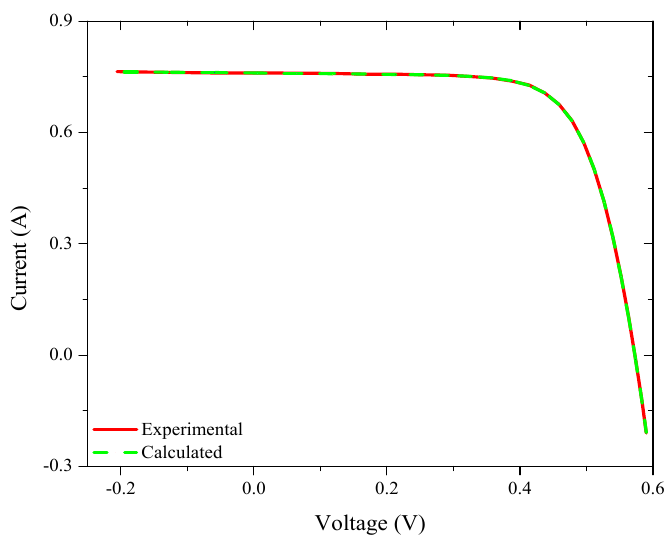
Figure 7. I–V curve for experimental and computed current values of DDM, solar cell.